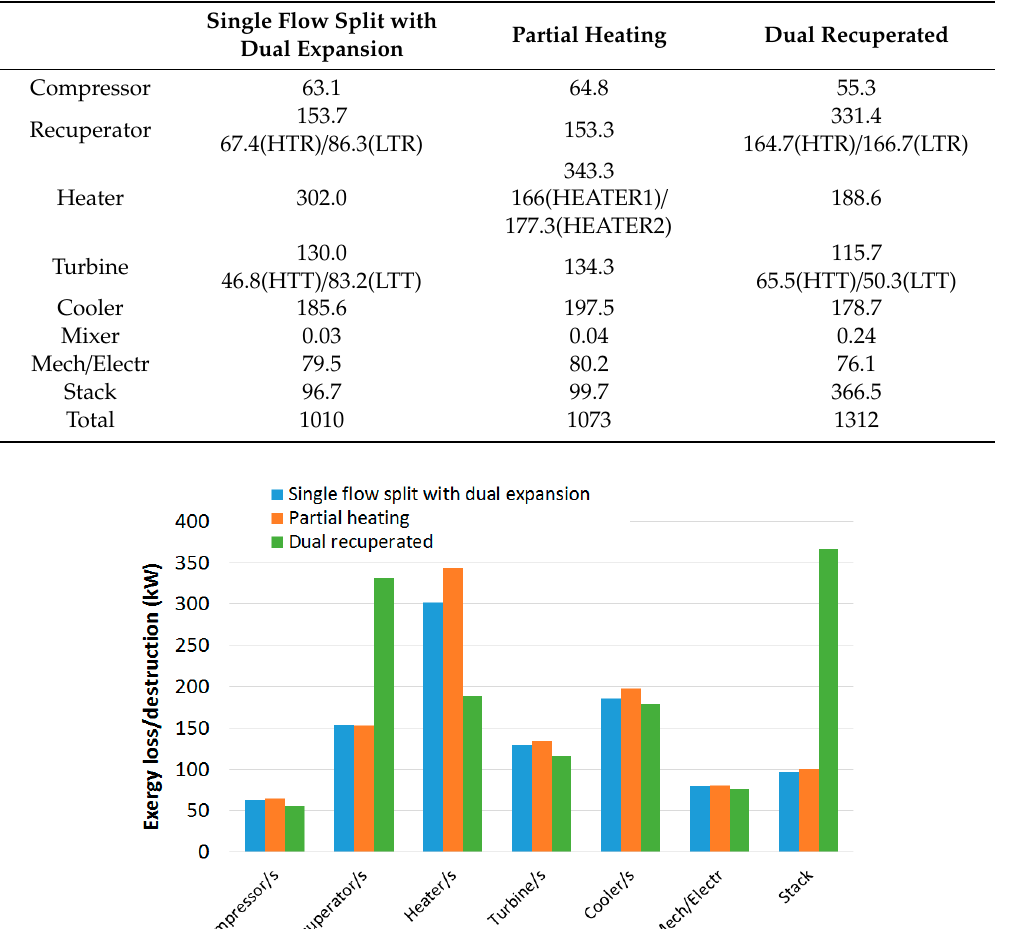
Table 10. Breakdown of the exergy losses/destructions for the three advanced s-CO 2 power cycles for WHR. All values are in kW.